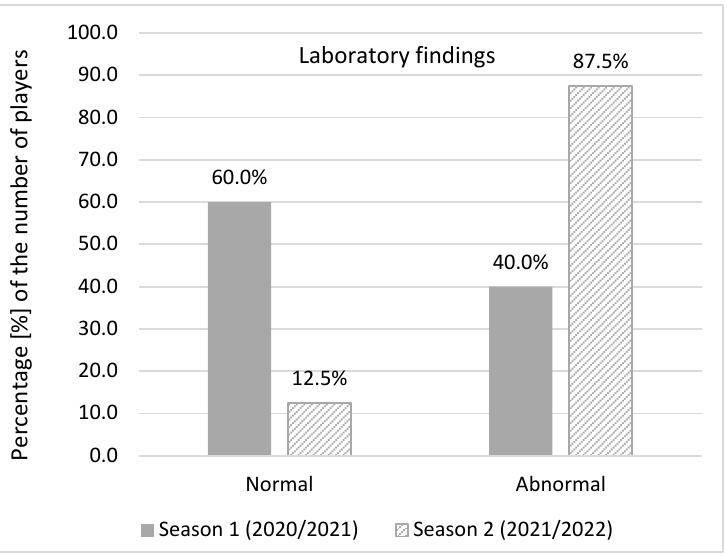
Figure 5. Abnormal laboratory findings.